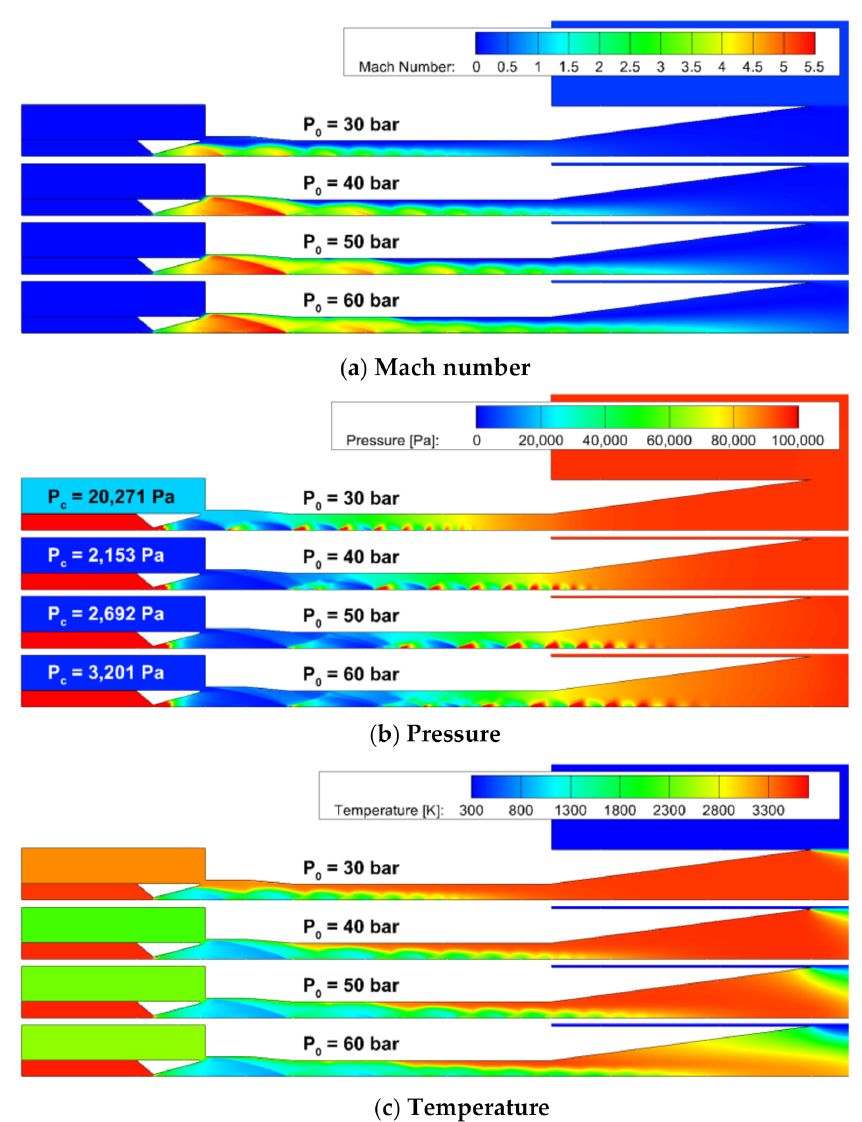
Figure 5. Comparisons of the baseline diffuser for various P 0